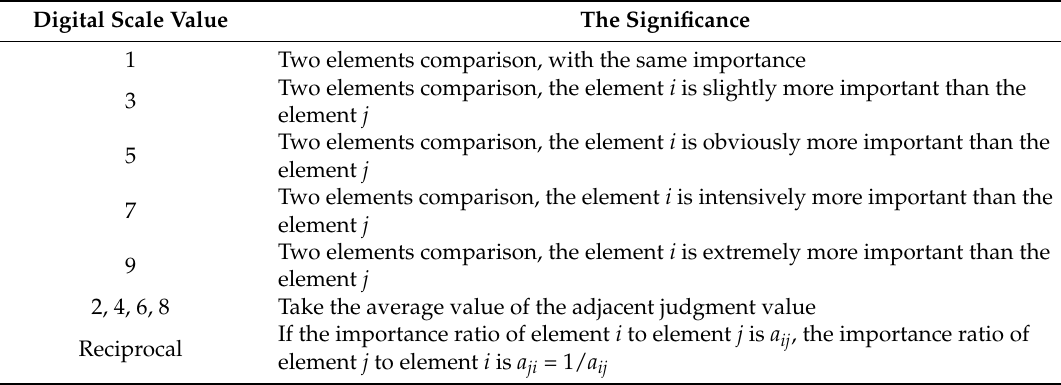
Table 1. Numeric scale and its